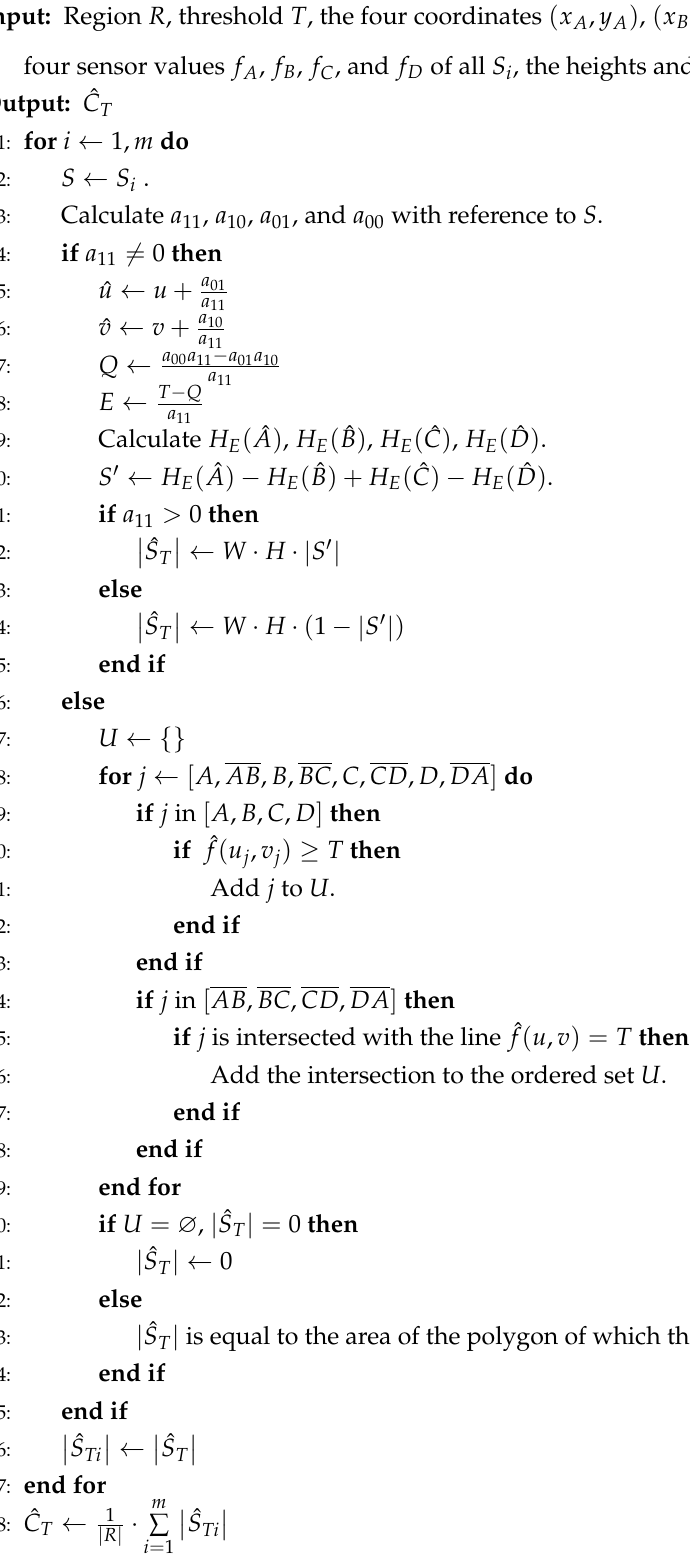
Algorithm 1 BIB